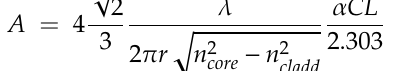
Figure S1: Figure S1.Plot of absorbance vs. [(CTA + ) 2 uranine 2 − ] aq .; Figure S2. Plot of absorbance vs. [(CTA + ) 2 uranine 2 − ]